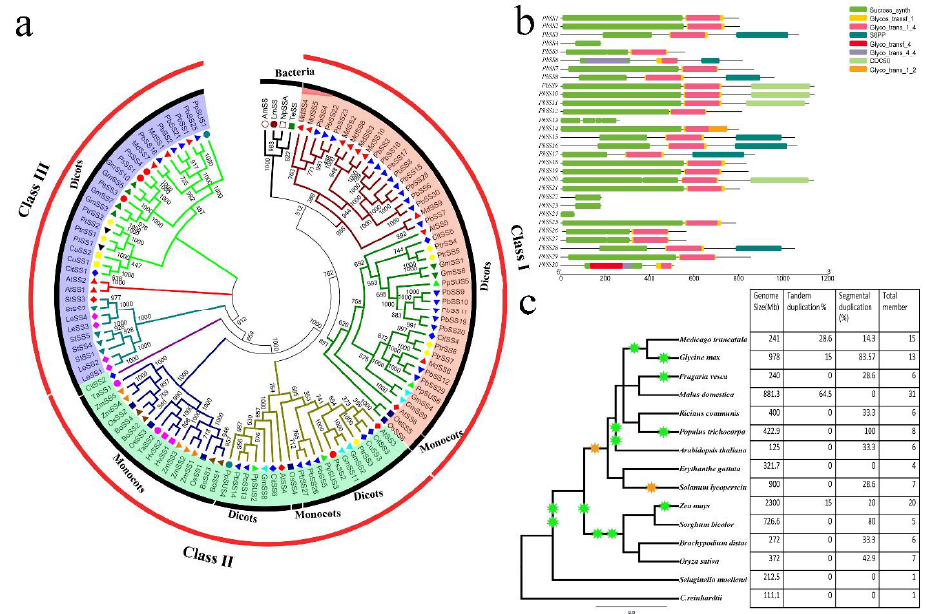
Figure 2. Phylogenetic relationships and domain structures of the sucrose synthase genes. ( a ) Phylogenetic analysis of pear sucrose synthase genes with other ten species (Supplementary Table S2) ( b ) Domain structures of the sucrose synthase proteins. Sucrose_synth indicated sucrose synthase domains. ( c ) The phylogenetic tree was generated by using NCBI database (https://www.ncbi.nlm.nih.gov/Taxonomy/CommonTree/wwwcmt.cgi) and presented the history of whole genome duplication of fifteen species. Green and dark orange specify whole genome duplication and triplication, respectively.